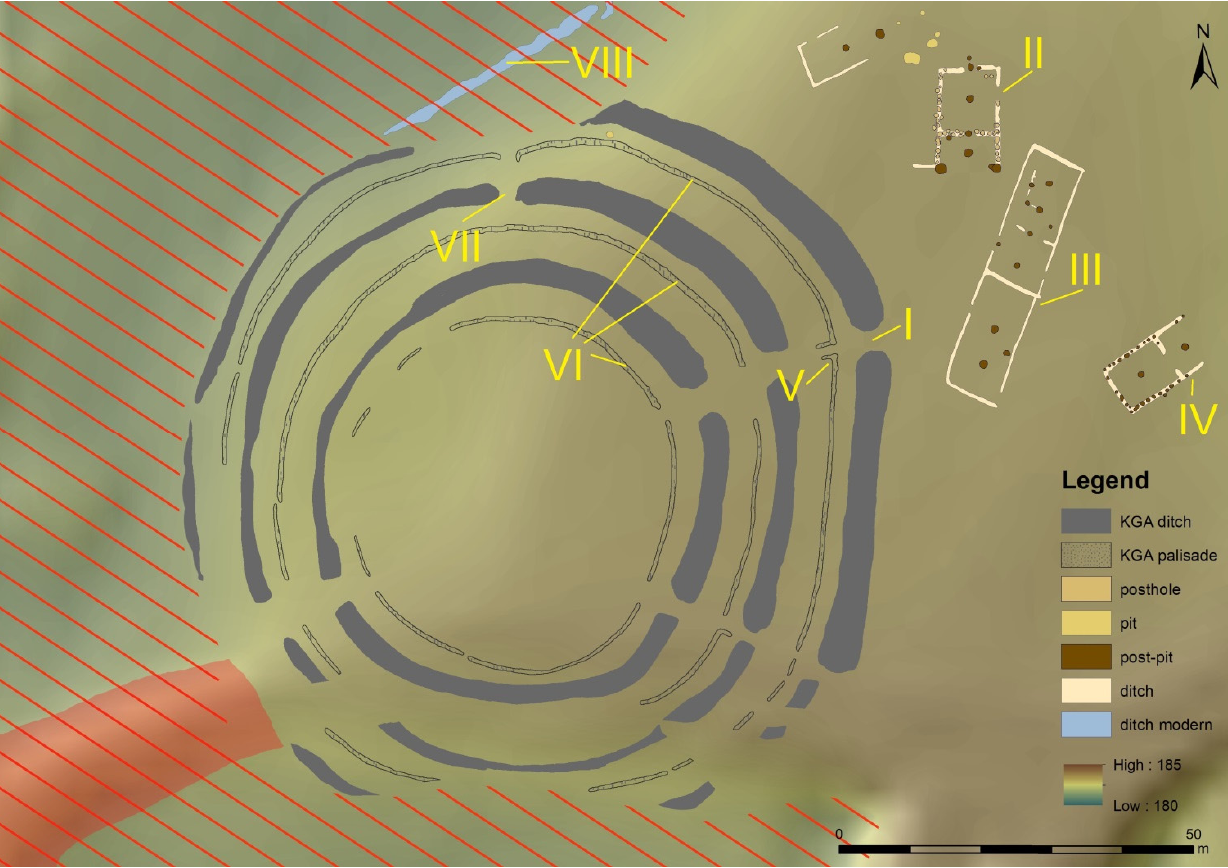
Figure 9. Archaeological interpretation of the GPR surveys in 2016, showing the position of the KGA on the slightly elevated gravel plain. The Roman numerals refer to the archaeological interpretation noted in the text. I—entrance area to KGA, II—building, III—second building, IV—third building, V—L-shaped palisade terminal, VI—the three palisades of the KGA, VII—northern entrance are, VIII—ditch for modern water management. Area hashed in dark orange indicates the floodplain of the river Kalter Gang. The area in red (bottom left) shows the embankment of a modern road.